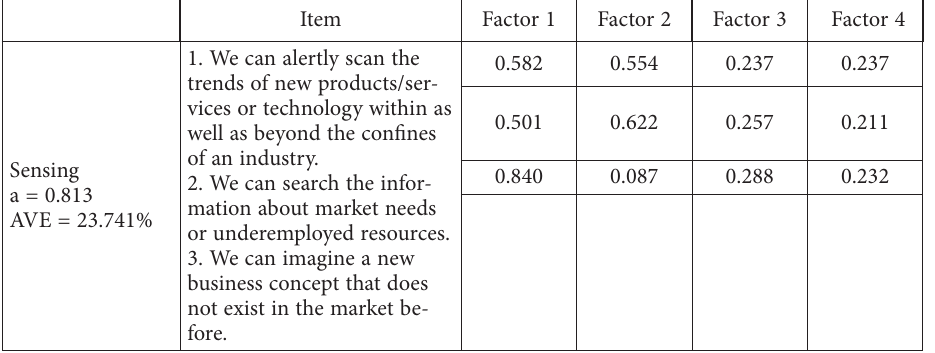
Table 4. The reliability and validity of entrepreneurial capability items